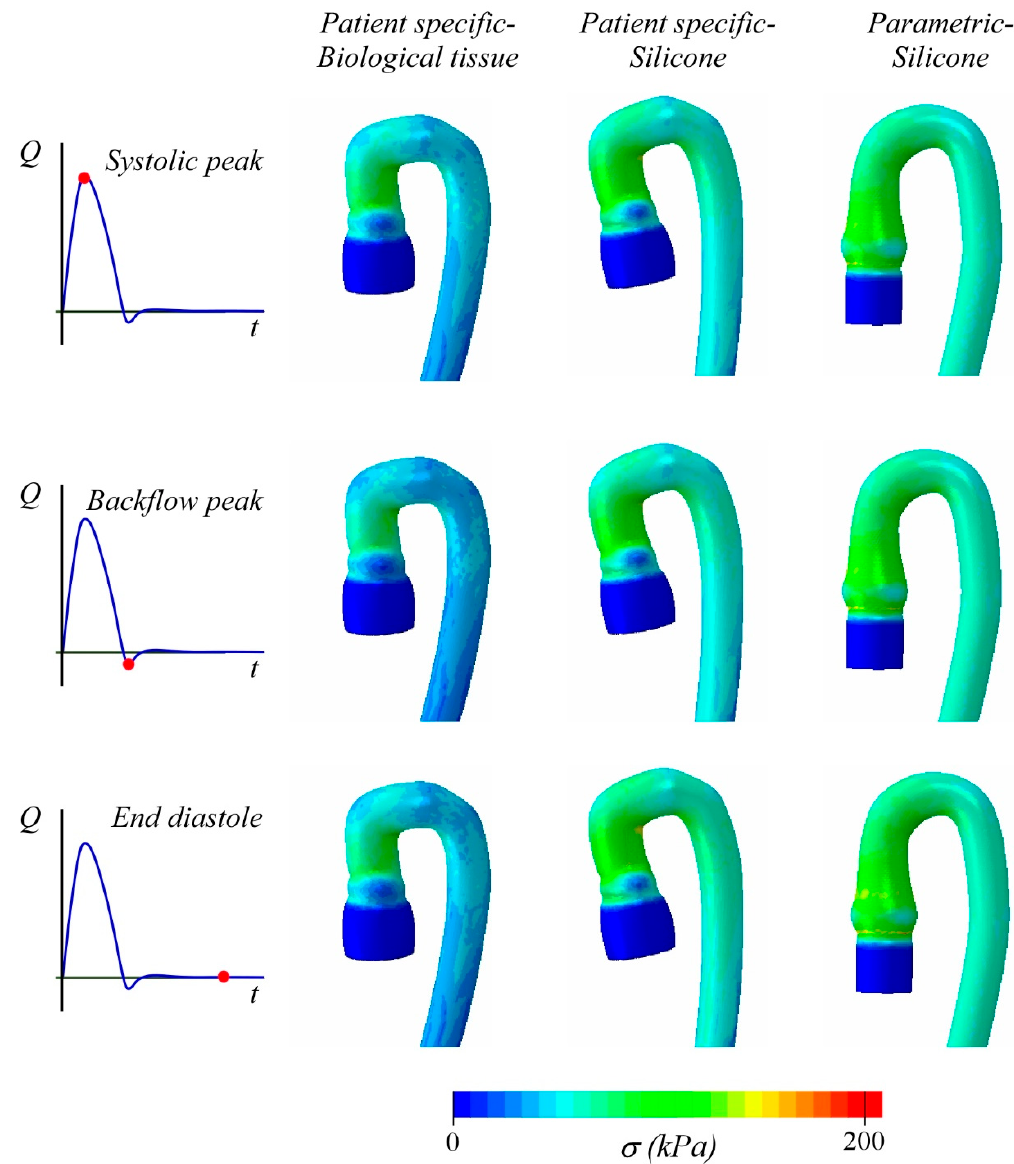
Figure 7. Principal stress corresponding to the strain field reported in Figure